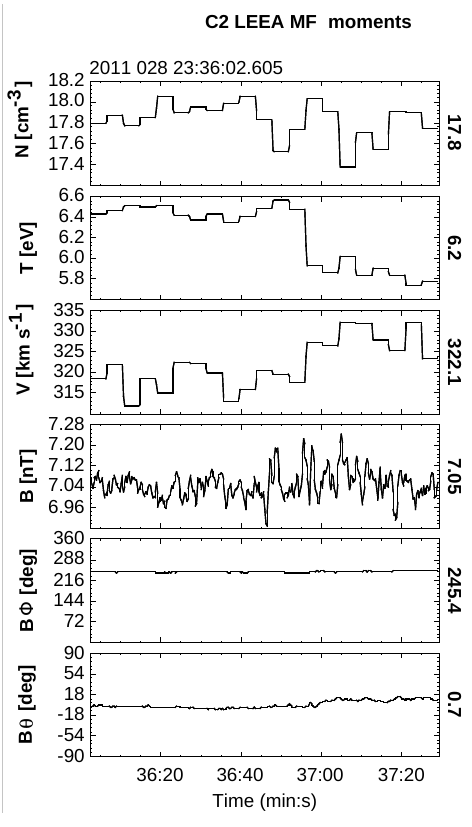
Figure 17. Identical to Fig. 9 but covering the narrow interval of time surrounding the transition between plasma with and without a strahl presence near 23:56UT in Fig. 12. While there appears to be a large rotation in phase at this point in Fig. 12, what the figure really shows is a directional change in the flow as the strahl drops out of the eVDF. This occurs where the spacecraft might be transitioning between adjacent flux